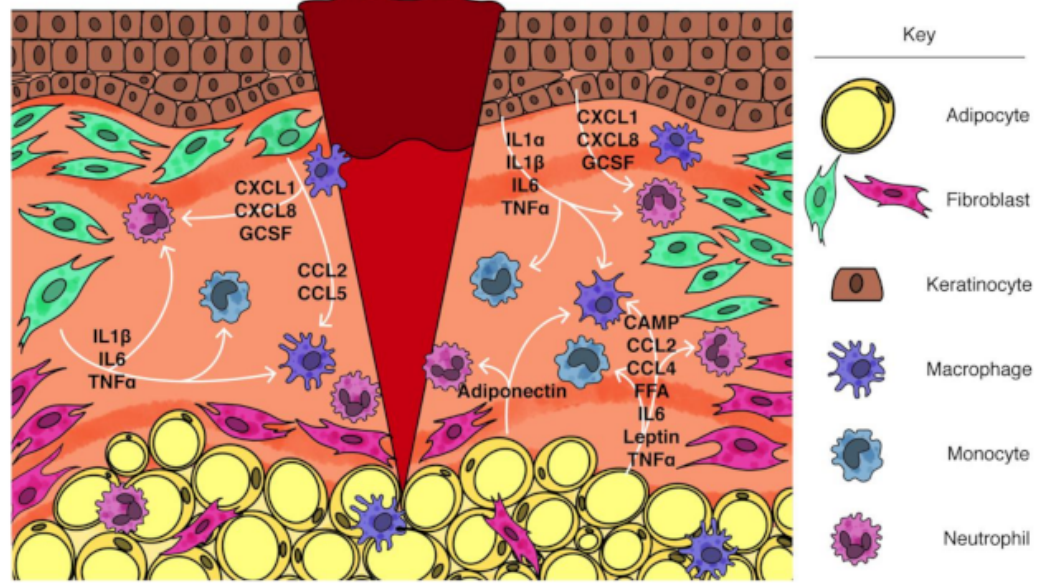
Figure 1. Regulation of injury-induced inflammation by skin-resident cells. After injury, skin-resident cells release factors that promote inflammation. Arrows indicate factors secreted from keratinocytes, adipocytes, and fibroblasts and the prospective leukocyte interactions during wound healing. CAMP, cathelicidin antimicrobial peptide; CCL, chemokine (C-C motif) ligand; CXCL, chemokine (C-X-C motif) ligand; FFA, free fatty acid; GCSF, granulocyte colony stimulating factor; IL, interleukin; TNF, tumor necrosis